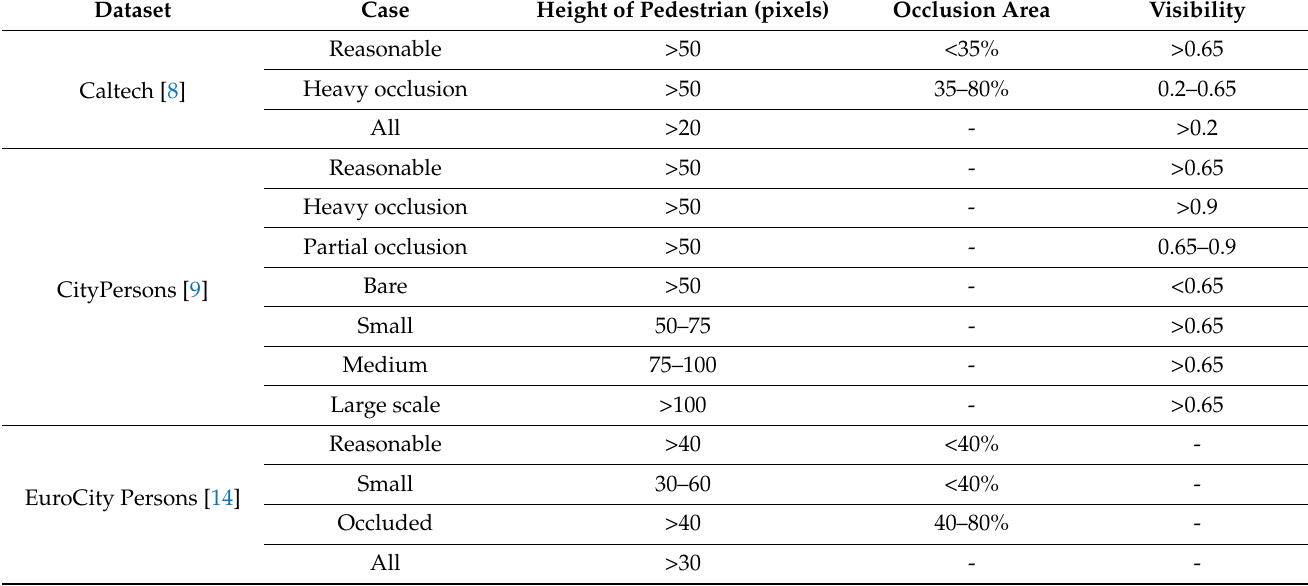
Table 1. Benchmark datasets used for pedestrian